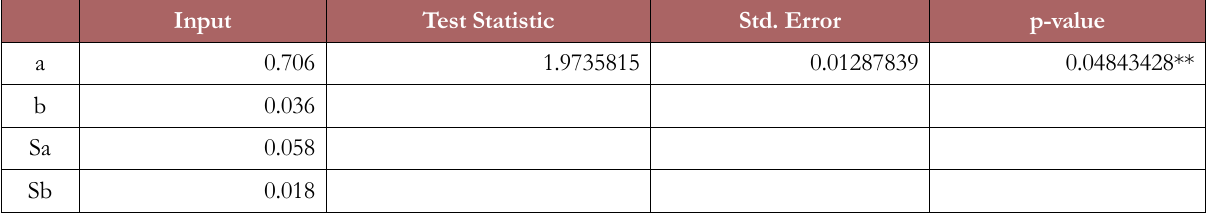
Table 4. Mediation Test Results